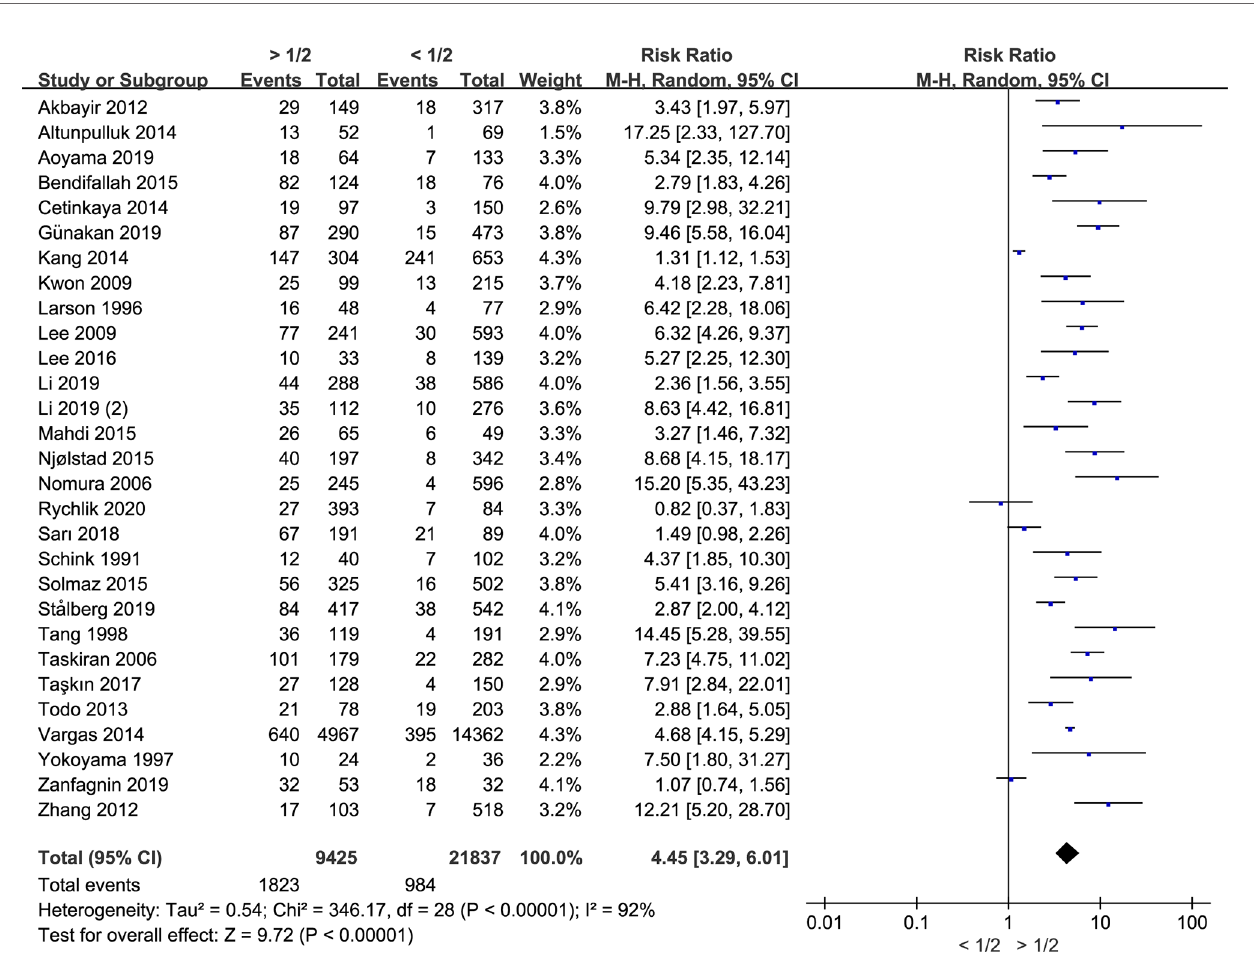
FIGURE 2 | Meta-analysis of the association between myometrial invasion and LNM in endometrial cancer.